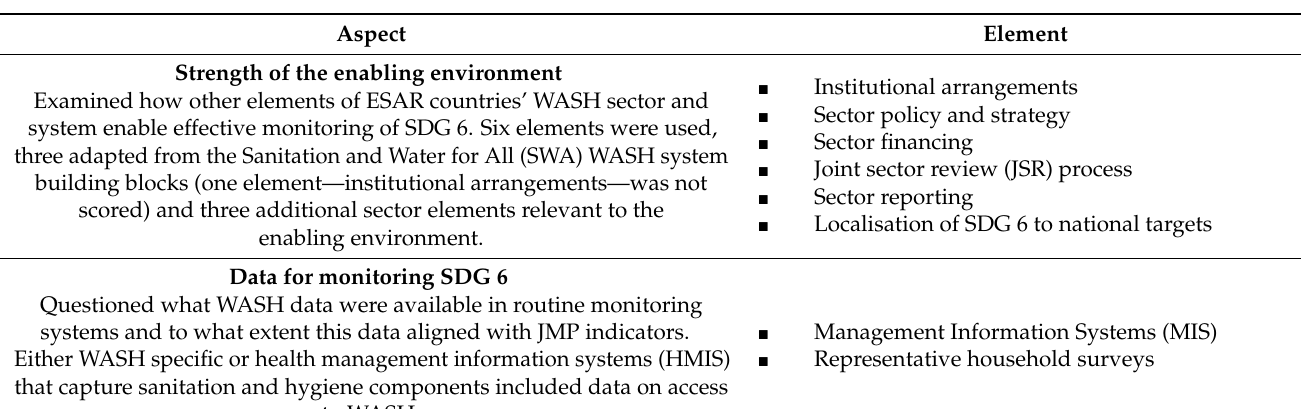
Table 1. Main aspects and key elements applied for the rapid assessment. Aspect